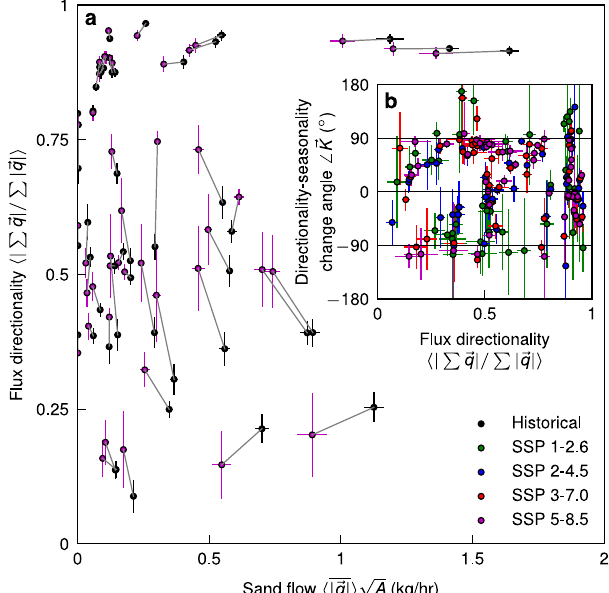
Fig. 4 Seasonality and slower, unidirectional dunes. a Sand fl ow, the product of a sand sea's fl ux hj q ! ji (kg/m/hr) and average width against fl ux directionality hj ∑ q ! j = ∑ j q ! ji for all sand seas in decadal averages for 2005 – 2014 (black dots) and 2091 – 2100 in the highest radiative forcing case SSP 5 – 8.5 (purple dots) linked for each sand sea with grey vectors. b Flux directionality against the angle of vectors ff K ! Figure S5: ff K is the sensitivity of change in the fl ux directionality hj ∑ q ! j = ∑ j q ! ji to change in the fl ux seasonality from 2005 – 2014 to 2091 – 2100 in each SSP scenario (different colors denoted in the legend). If ! ff K > 0 (cid:6) then fl ux directionality increases in the future, and if ! (cid:4) 90 (cid:6) > ff K > 90 (cid:6) then seasonality increases in the future. A sand sea's fl ux seasonality is de fi ned as the proportion of annual fl ux ∑ hj q ! ji (kg/m/s) that occurs during the quarter (consecutive 3-month period) of the year with the most fl ux, max fhj q ! jig (kg/m/s). All dots have ± 1 ensemble standard deviation error